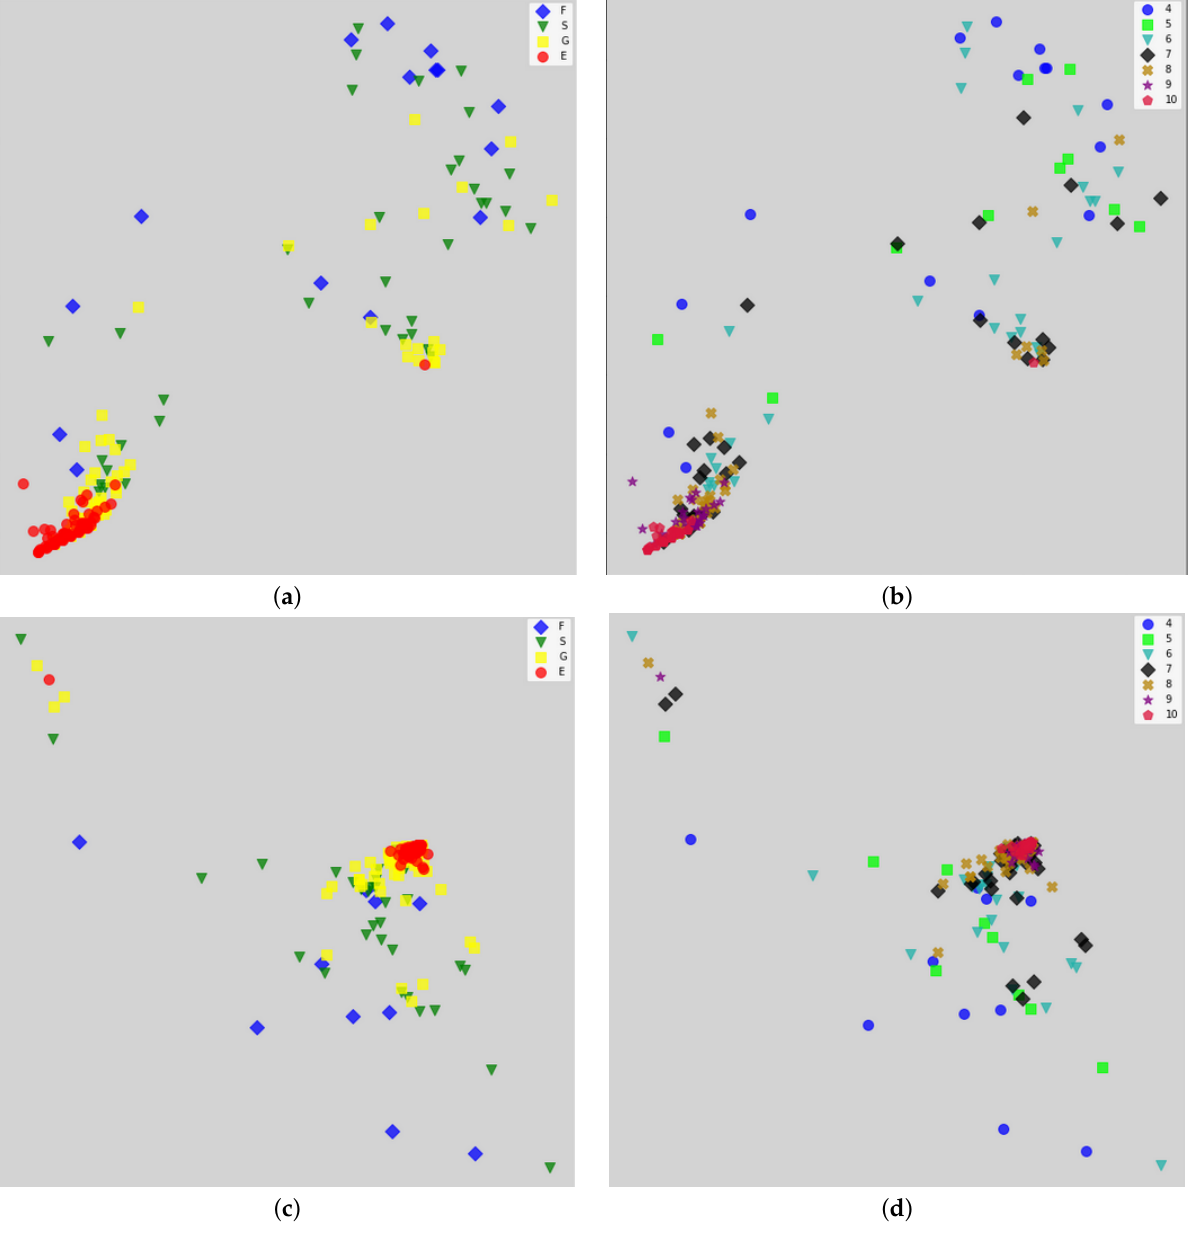
Figure 3. AE visualizations for the first case study: data set D t and the category ( a ) and grade -based classifications ( b ); data set D o and the category ( c ) and grade -based classifications ( d